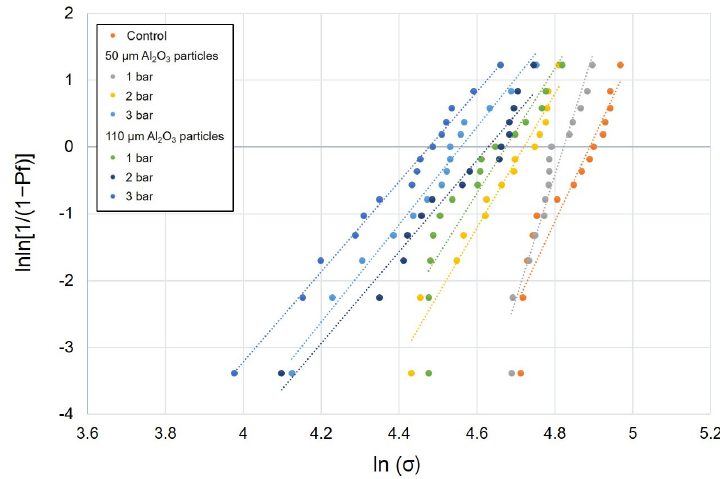
Figure 5. Weibull plot of polymer-infiltrated ceramic networks specimens subjected to air abrasion with alumina particles of different sizes at different pressures.